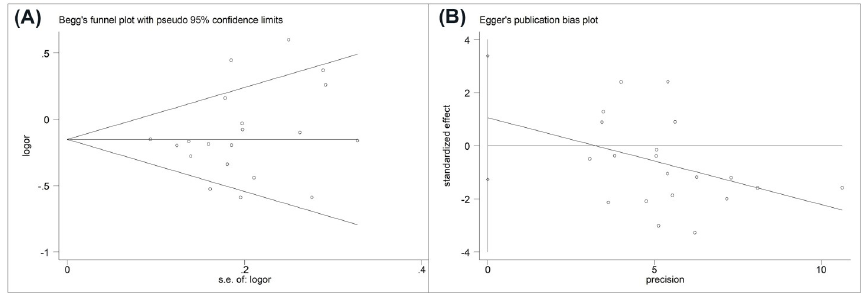
Fig 5. Funnel plot to assess the risk of publication bias in the meta-analysis. (A) Begg’s funnel plot, (B) Egger’s publication bias plot.